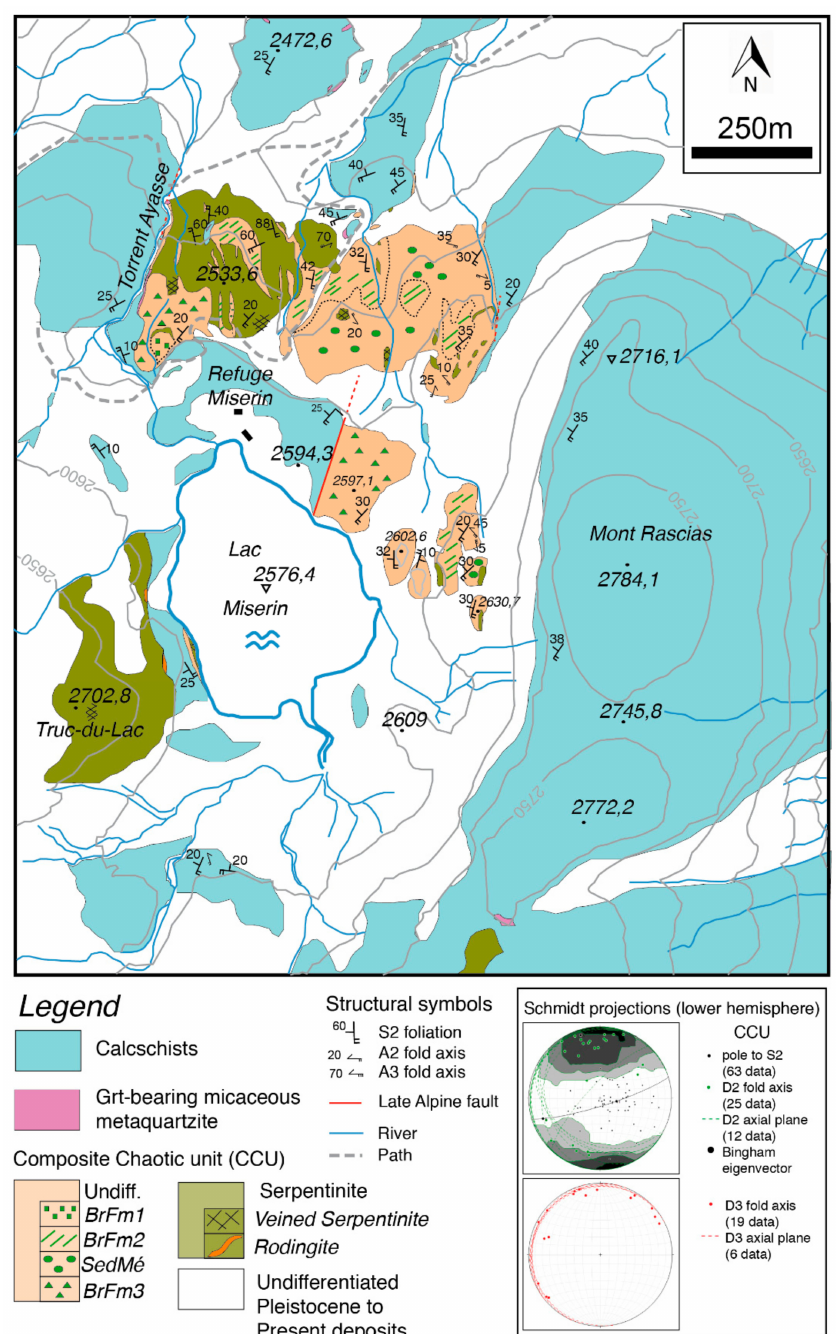
Figure 2. Geological map of the study area (from original field mapping at 1:5000 scale) and lower hemisphere projections of the main structural